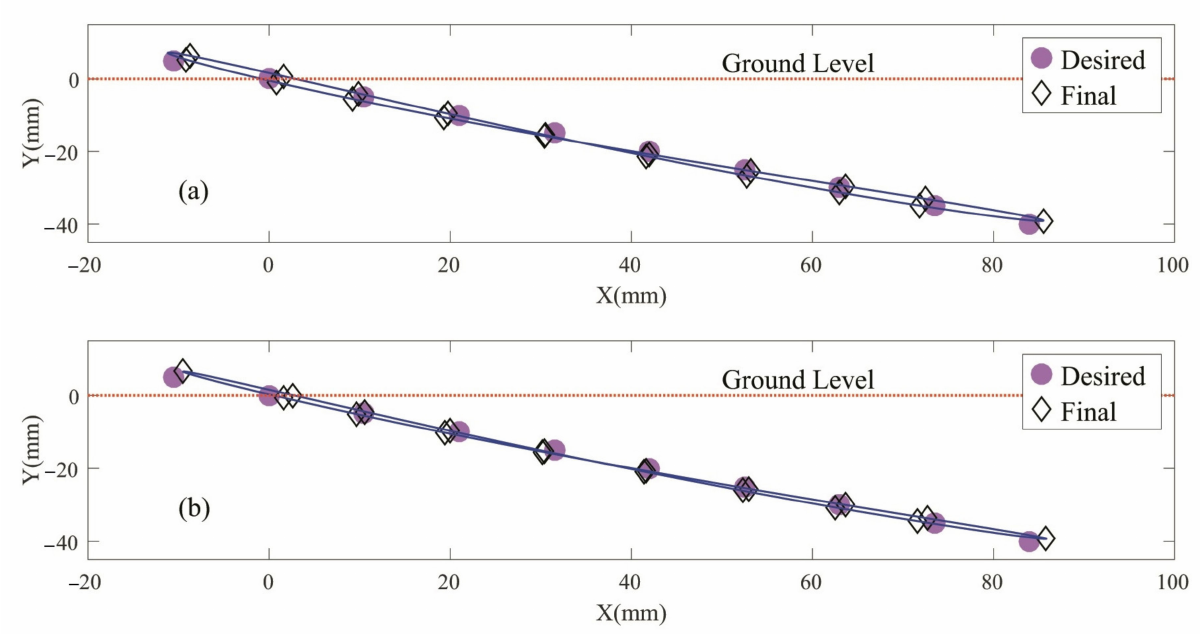
Figure 11. ( a ) HGA-based synthesized path, and ( b ) QNM-based synthesized